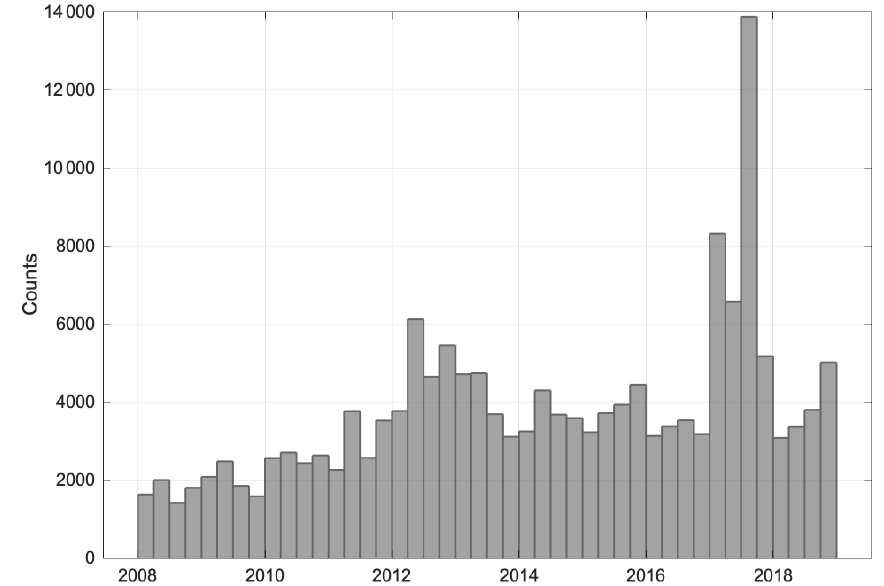
Figure 3. Earthquake – time histogram for the time interval 1 January 2008–31 December 2018.